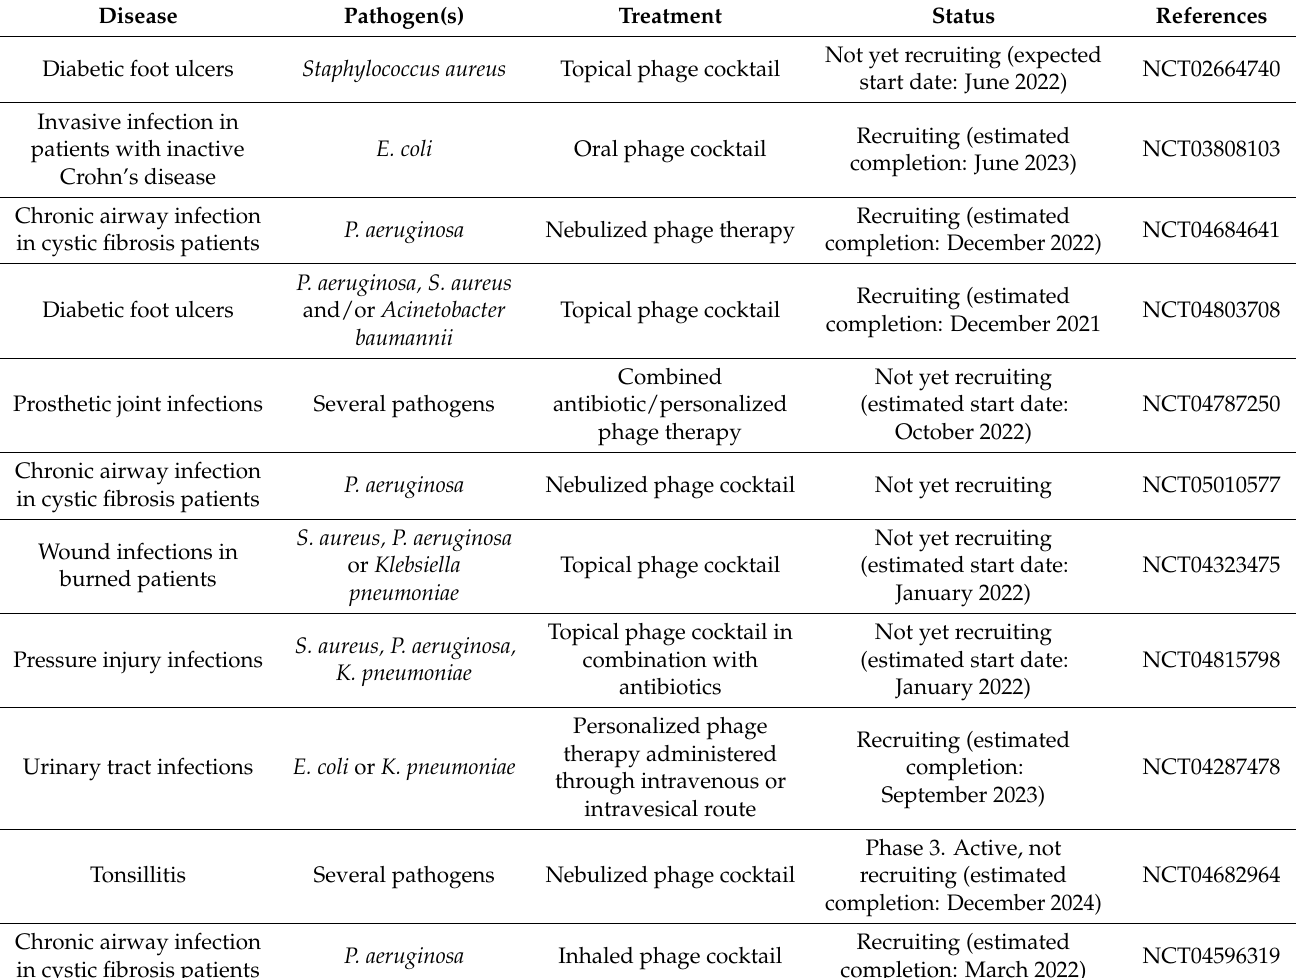
Table 1. Ongoing clinical trial examples involving phage